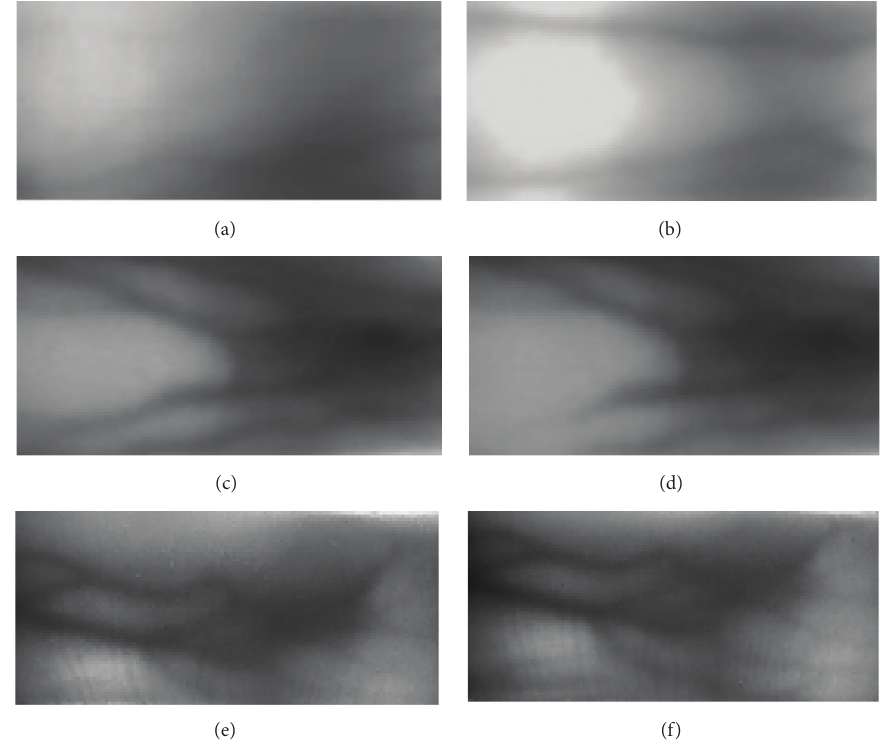
Figure 1: Low-quality finger vein image